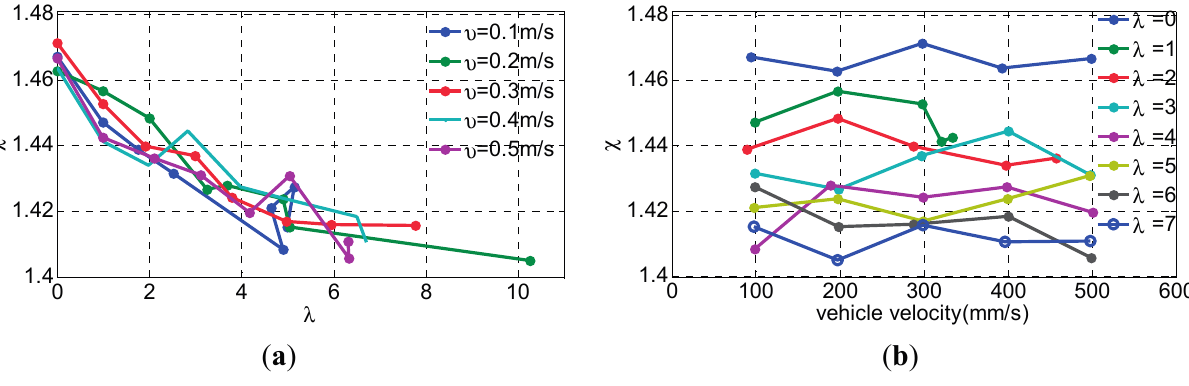
Figure 12. The calculated ICR coefficient χ for various: ( a ) path curvatures with (cid:1874) = 0.1, 0.2, … 0.5 (cid:1865)/(cid:1871) ; and ( b ) robot speeds with (cid:1874) = 0.1, 0.2, … 0.5 (cid:1865)/(cid:1871) with (cid:2019) = 0, 1, 2, … , 7